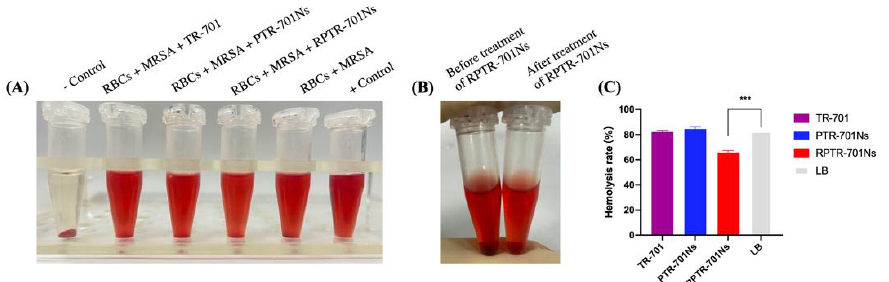
Figure 9. Exotoxin-removing capability of RPTR-701Ns. ( A ) Results of the anti-hemolysis of RPTR- 701Ns to exotoxins secreted different kinds of bacteria. Luria Bertani (LB) solution was set as the negative control and 0.1% Triton X-100 LB solution was set as the positive control. ( B ) RBCs treated before and after RPTR-701Ns and ( C ) Quantitative analysis of anti-hemolysis. Data were presented as mean ± SD, n = 6, *** p < 0.001.